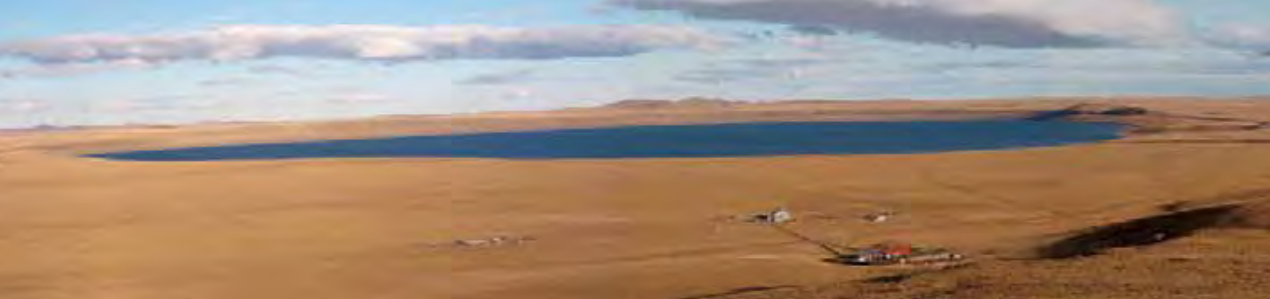
Figure 1. Overview of Laguna Potrok Aike from prominent basalt escarpment. This 770 ± 220 ka old maar lake is located at approximately 52°S, 70°W in Santa Cruz province, southern Patagonia (Argentina). Lake elevation = 113 m, depth = 100 m, and diameter = 3.5